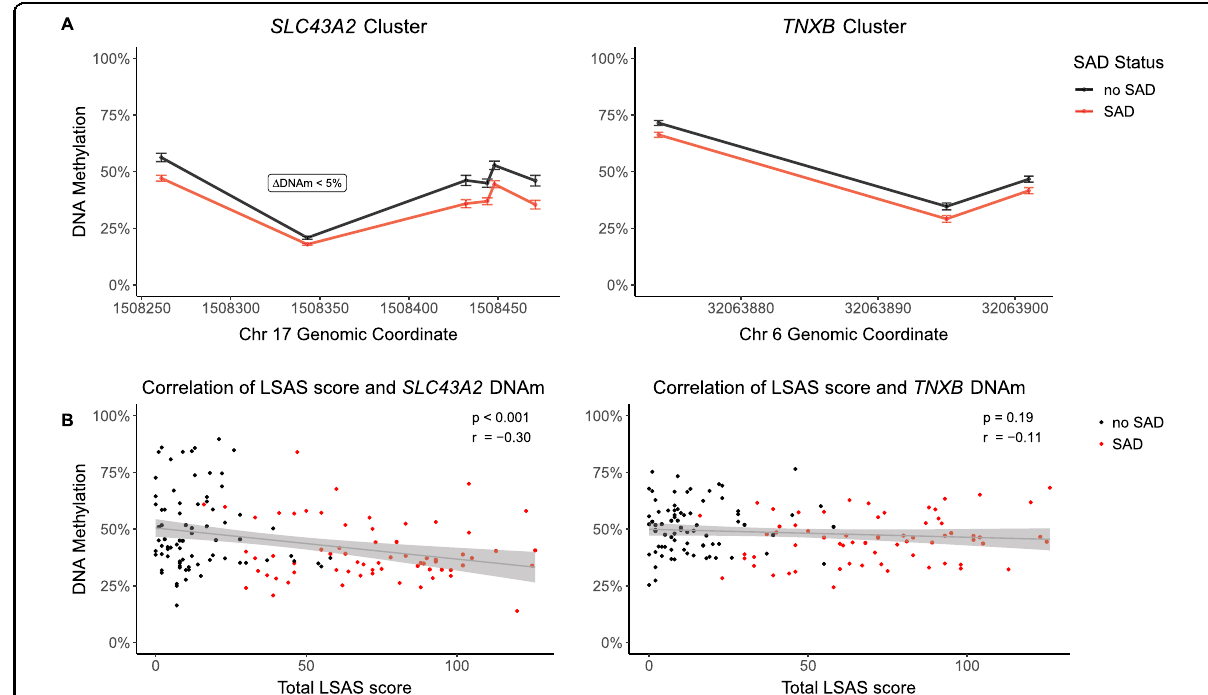
Fig. 1 DMRs with respect to SAD. A Group mean DNAm ± standard error within the top two DMRs associated with SAD ( n = 143). B Correlation of severity of social anxiety (LSAS score) with mean DNAm values of the SLC43A2 (left) and the TNXB cluster (right). Regression line with 0.95 con fi dence interval is